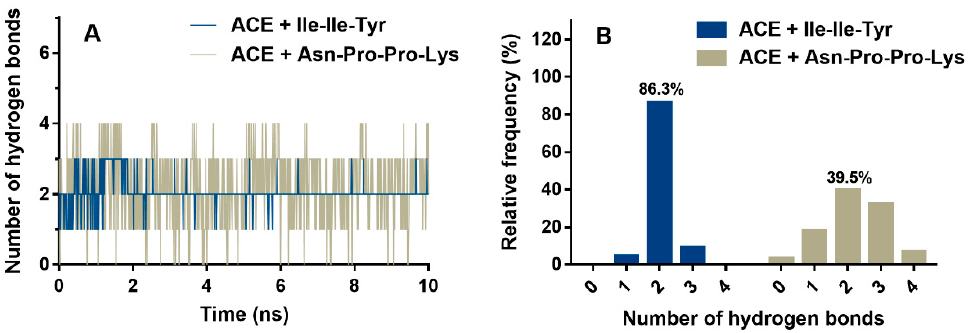
Figure 9. Number of hydrogen bonds between ACE and inhibitory peptides during molecular dynamics ( A ) and its frequency histogram ( B ).